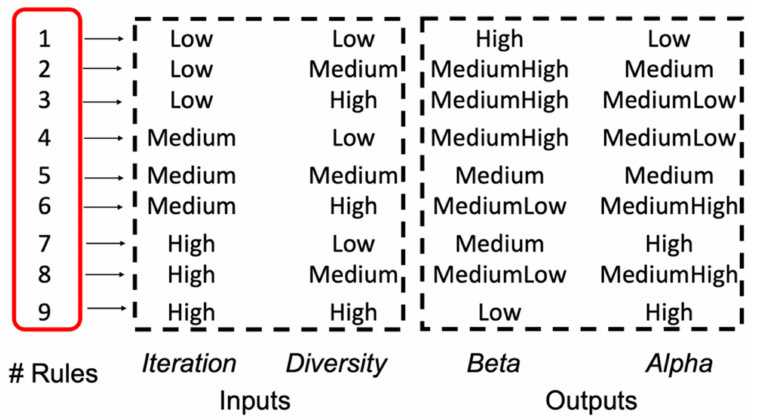
Figure 21. Rules for the Fuzzy BCO